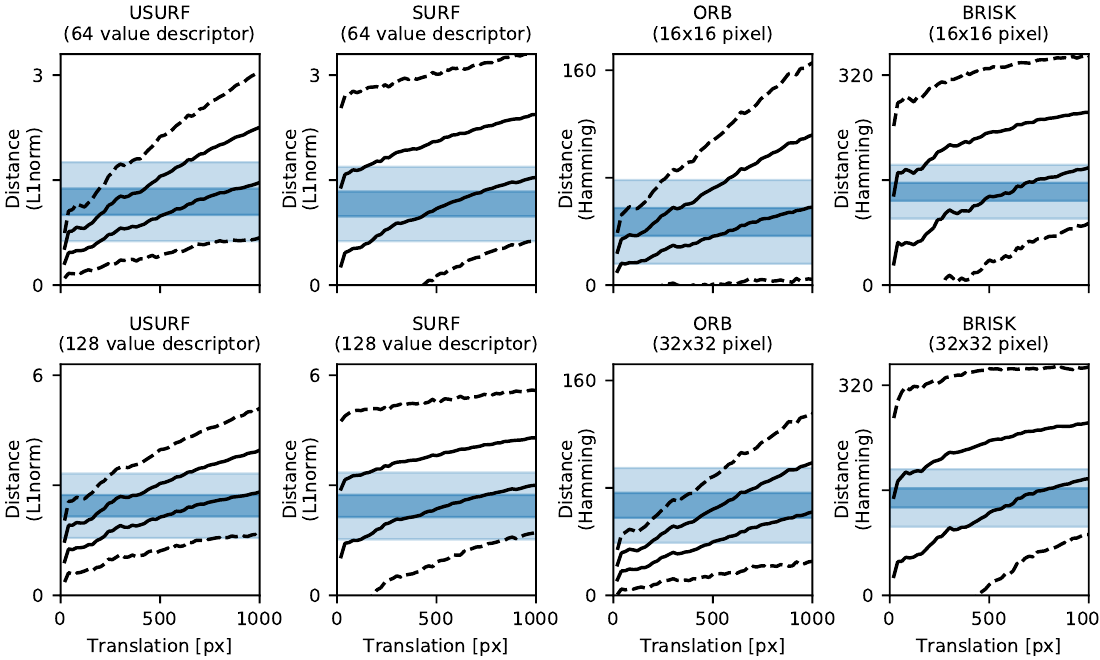
Figure 15. Descriptor discrimination for translation of the horizontal milling R z = 16 µ m sample. The shaded bands show the 1 and 3 standard deviation spread in the descriptor distances for ‘bad’ matches. The lines show the 1 and 3 standard deviation spread in the calculated distances for valid matches after